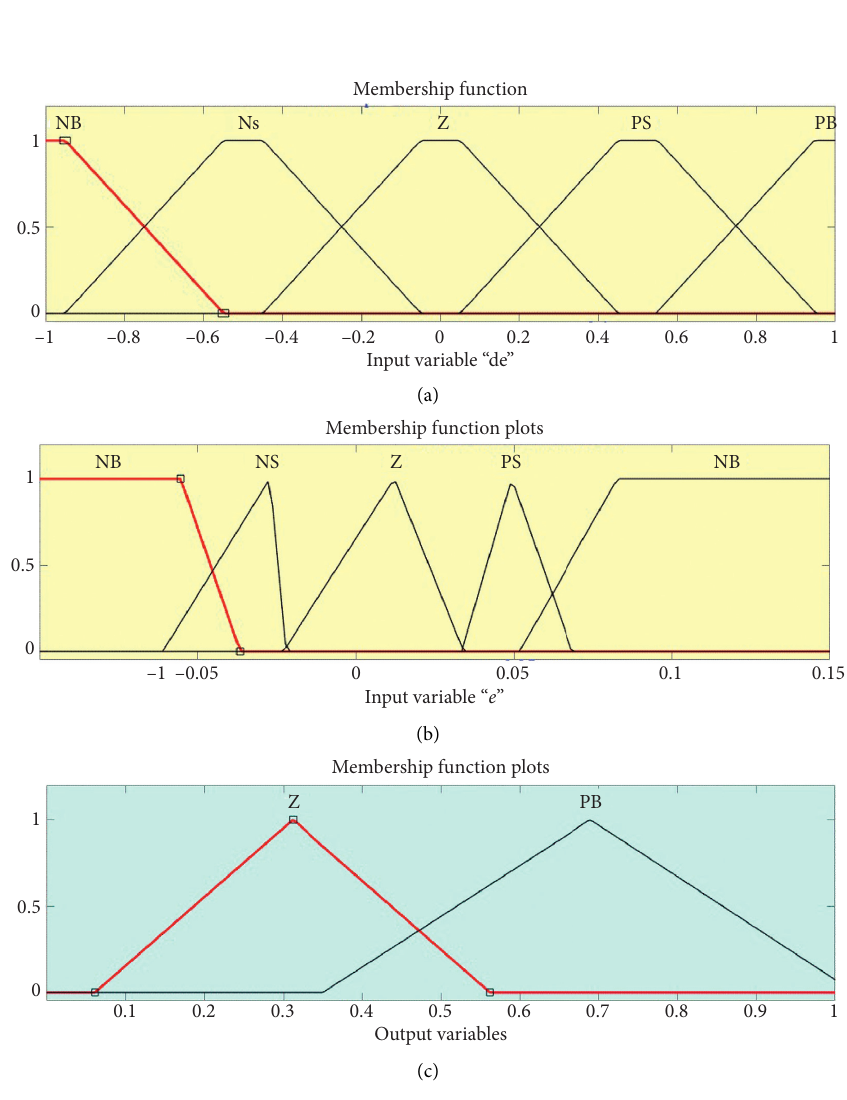
Figure 5: Triangular membership functions: (a) and (b) for input variables and (c) for output